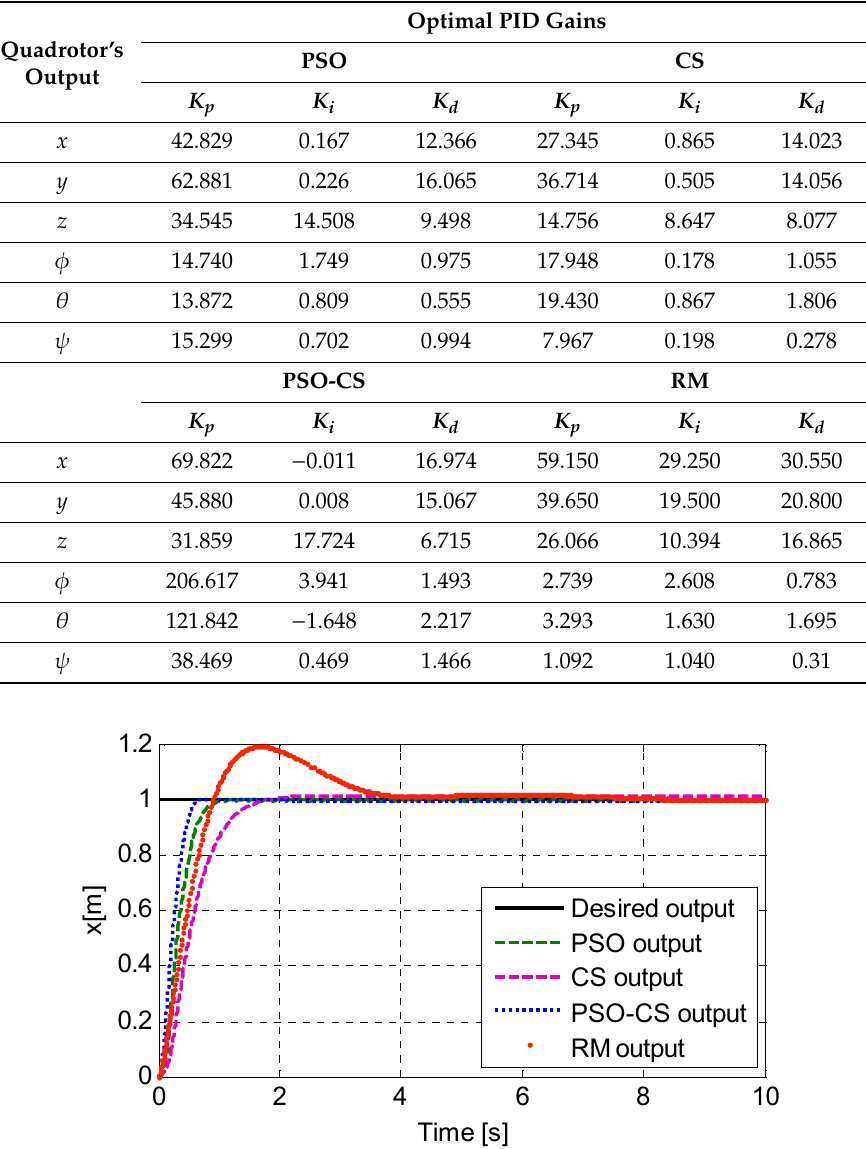
Table 3. Optimal Proportional, Integral and Derivative (PID) parameters obtained with Particle Swarm Optimization (PSO), Cuckoo Search (CS), Particle Swarm Optimization-Cuckoo Search (PSO-CS), and Reference Model (RM) for the quadrotor.